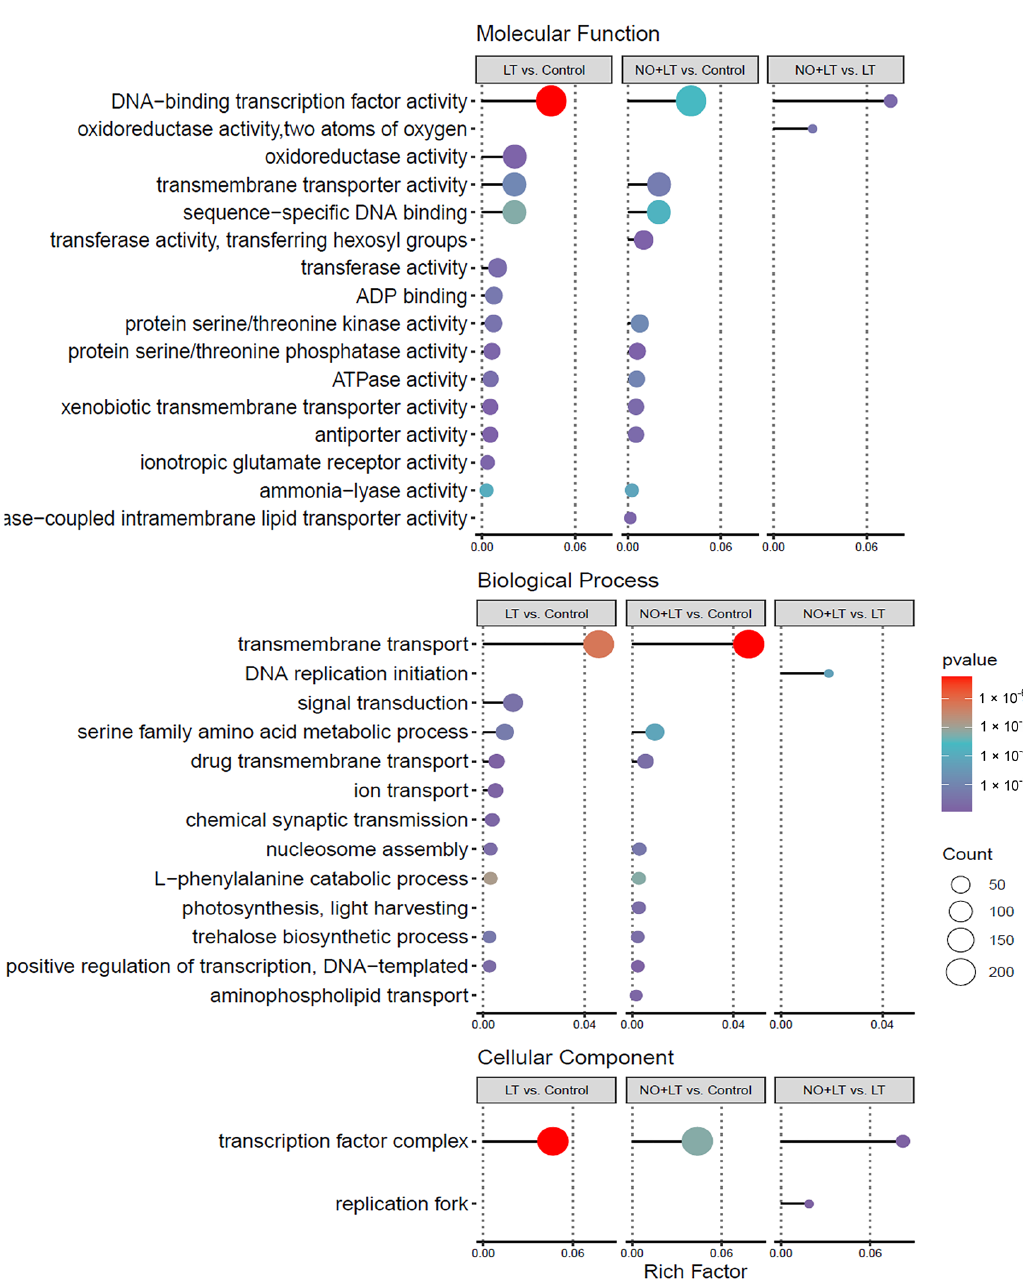
Figure 3. Gene ontology (GO) enrichment analysis of differentially expressed genes (DEGs) for LT vs. Control, NO + LT vs. Control, and NO + LT vs. LT. The color gradient represents the size of the p -value and the size of the circle represents the number of DEGs. The BP, CC, and MF represent biological processes, cellular components, and molecular functions, respectively.